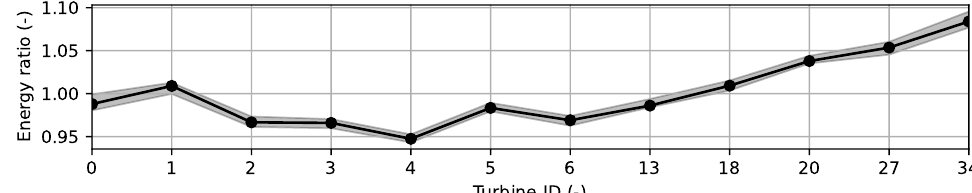
Figure 7. The energy ratios for all upstream wind turbines at the Westermost Rough wind farm normalized to the average of all turbines for a wind sector of 262.5 ◦ to 277.5 ◦ , equal to wind coming from the west. For this wind direction, turbines central in the farm (e.g., T3, T4) generate up to 5% less energy than the average of all upstream turbines, whereas turbines far north in the farm (e.g., T27, T34) generate 5%–8% more. The shaded region represents 90% confidence